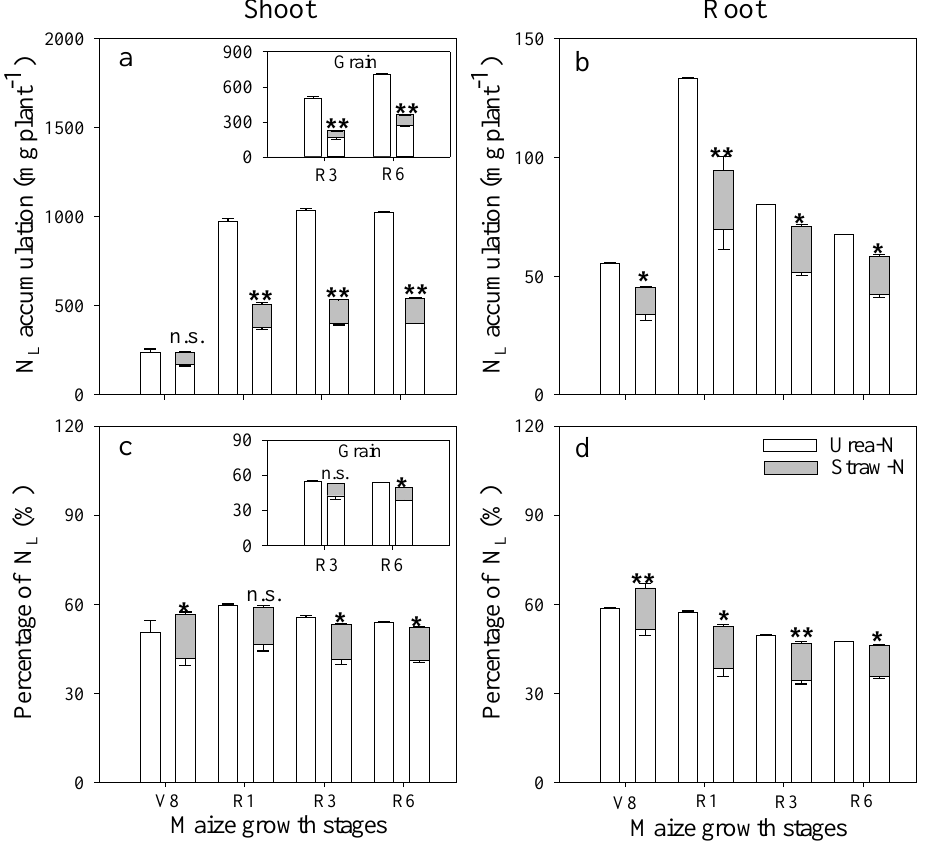
Figure 2. Concentration ( a , b ) and percentage ( c , d ) of labeled applied N (N L ) present as N taken up by maize shoots, grains, and roots in different fertilizer treatment during maize growth. White-only bars represent urea treatment (U). White plus gray bars represent urea combined with straw treatment (US). Maize growth stage: V8, R1, R3, and R6 respectively represent 8th leaf stage, silking stage, milk stage, and physiological maturity. Data shown are mean ± standard deviation of three replicates; * and ** denote significant differences at p < 0.05 and p < 0.01, respectively; n.s., not significant ( p > 0.05). Shoot N includes leaf, stem, cob, husk, and grain fractions (all whole-plant fractions except roots).